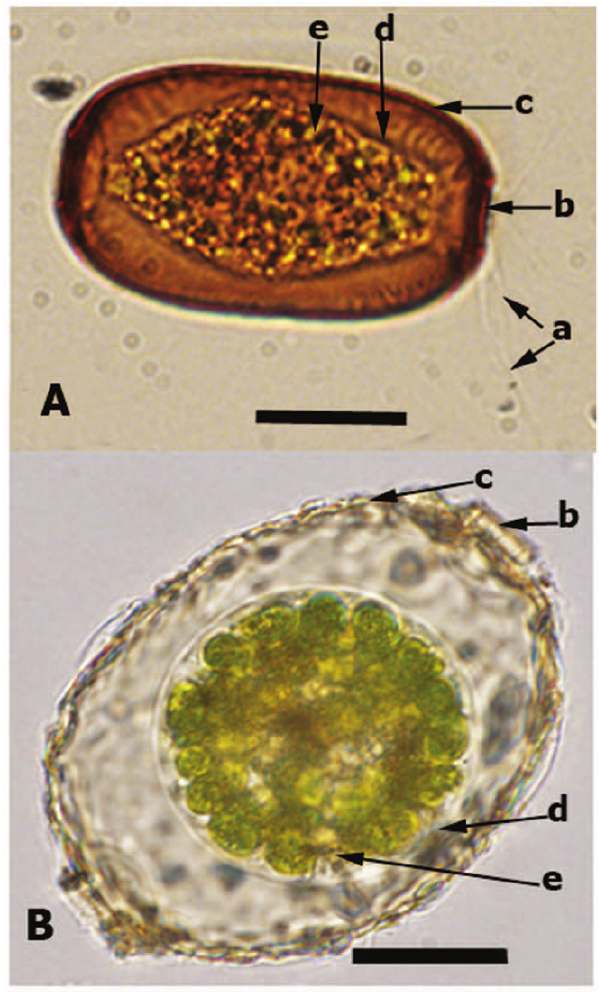
Figure 1. Light microscopy photograph for Archerellaflavum (A) and Amphitremawrightianum (B): the arrows indicate a) filose pseudopodia; b) pseudostome (shell aperture); c) shell (test); d) cell membrane; e) endosymbioitic green algae. Scale bar=20 m m.